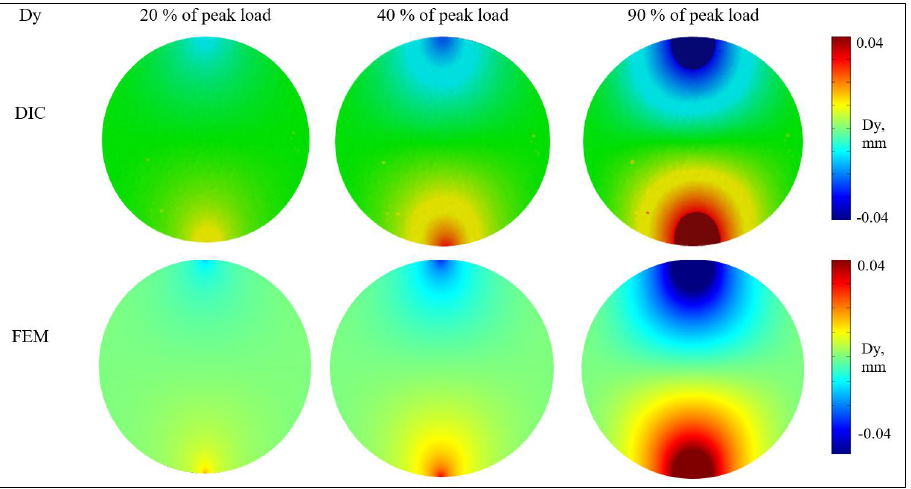
Figure 11. Changes in vertical displacement contour ( Dy ) along the centerline: DIC vs. simulation results.